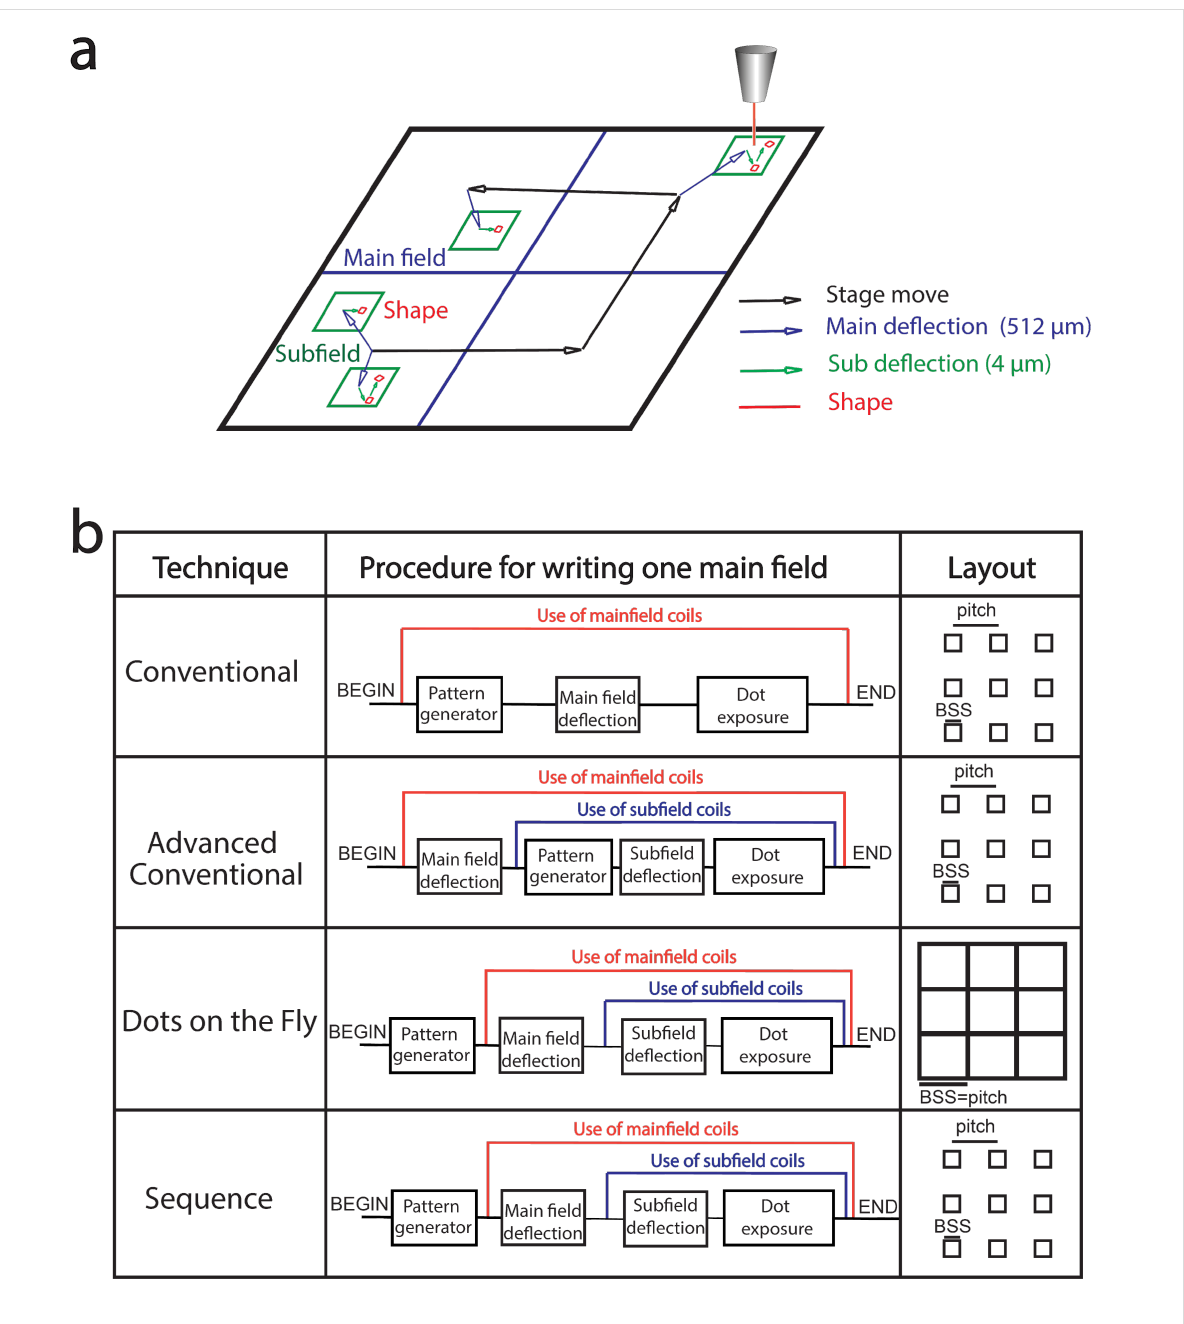
Figure 1: a) Schematic description of the writing strategy in e-beam lithography. The beam is deflected into a main field ( ≈ 512 µm) thanks to 2 sets of scanning coils, and to write a complete pattern, the stage moves from one main field to the other one. b) Schematic description of the 4 e-beam lithog- raphy techniques compared for their writing sequence inside a main field and their layout (BSS is the beam step size).